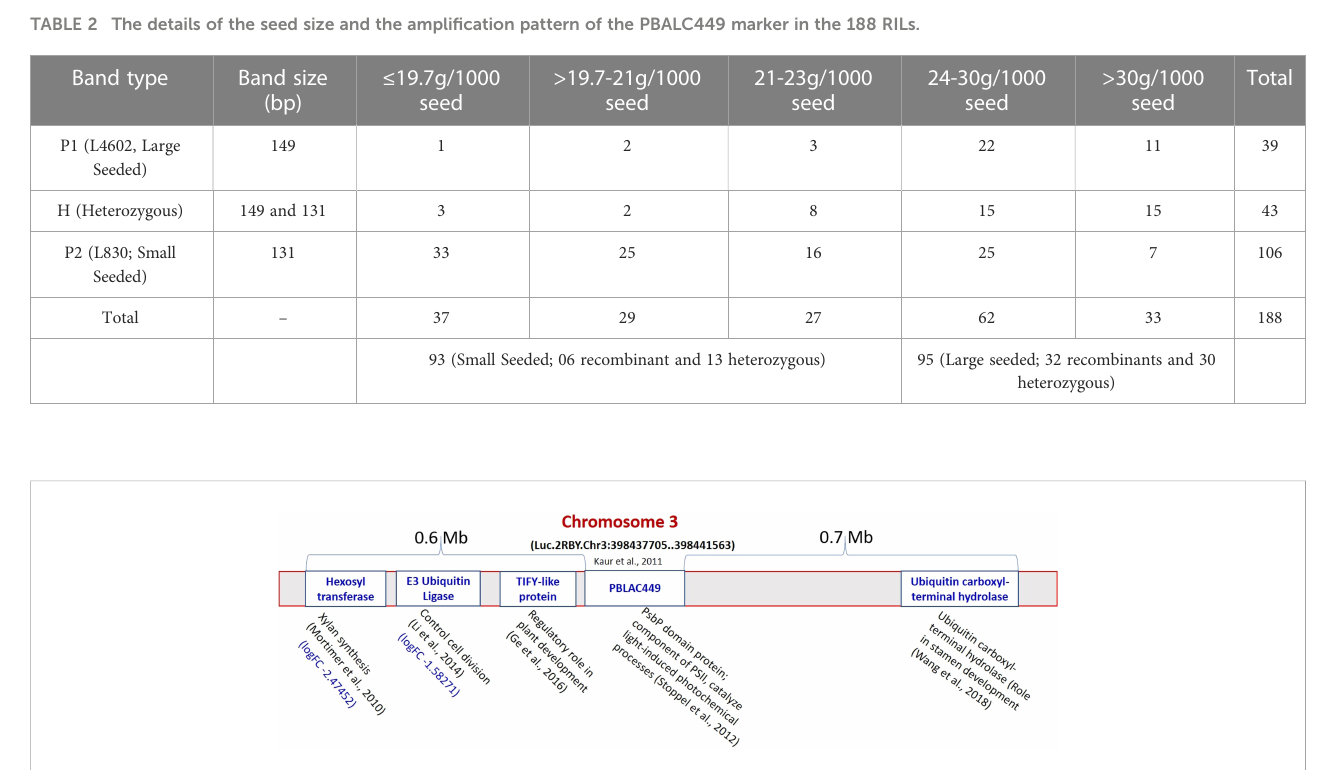
FIGURE 6 Putative genes identi fi ed regulating seed size on both sides (1.2 Mb region) of the PBALC449 in the lentil genome. (Derived from Mortimer et al., 2010; Stoppel et al., 2012; Li and Li, 2014; Ge et al., 2016; Wang et al., 2018).